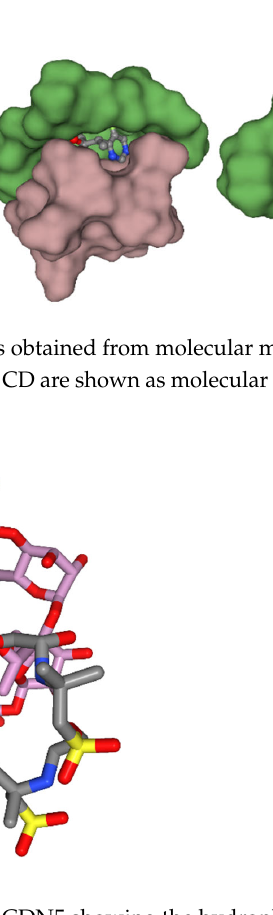
Figure 12. The amalgamation of CDN5 showing the hydrophobic contacts between the molecules.